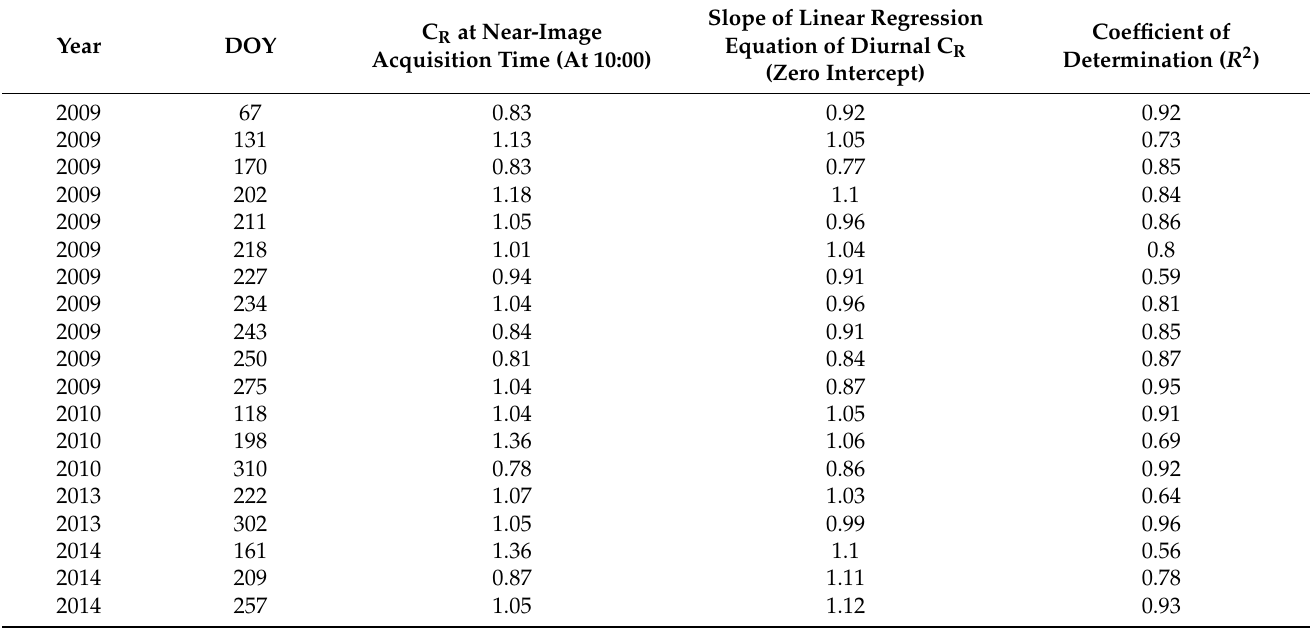
Table 2. The near-acquisition time C R , the slope of linear regression equation and the coefficient of determination of diurnal C R on the selected LS5 and LS8 image acquisition